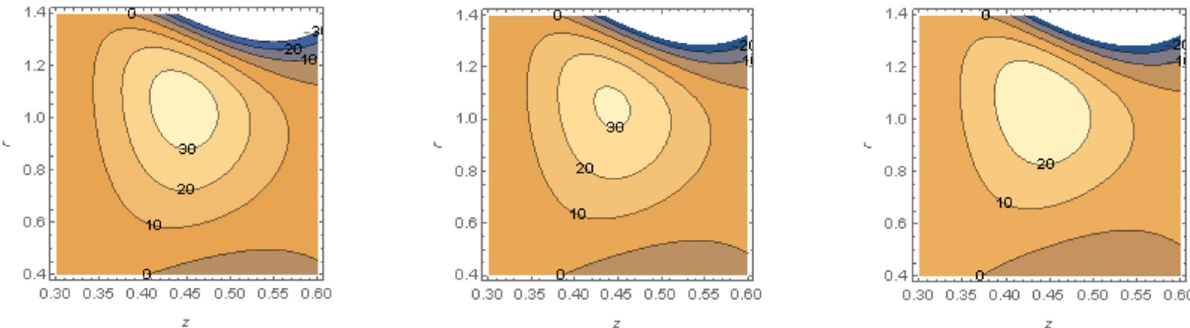
Figure 22: Various values of the wave frame streamlines of ϵ = { 0.150, 0.155, 0.160 } at